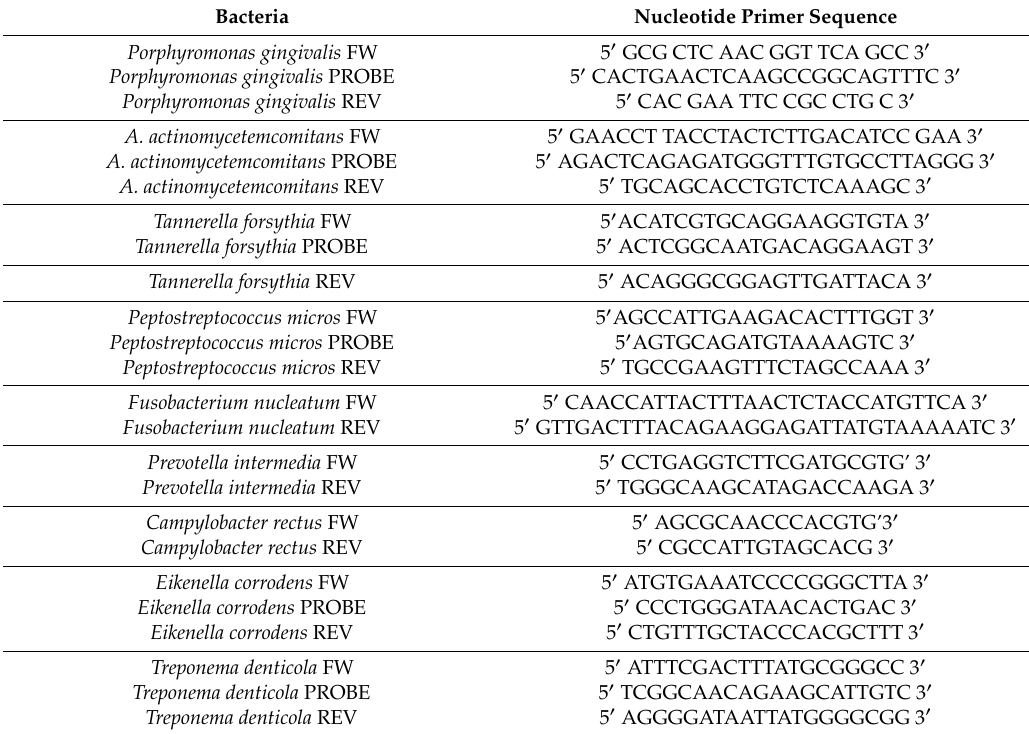
Table 3. Bacteria used as specific biomarkers for the comparison among the results obtained with massive sequencing on the microbiological samples of the various patient groups. Massive sequencing can identify all the genes recognized by